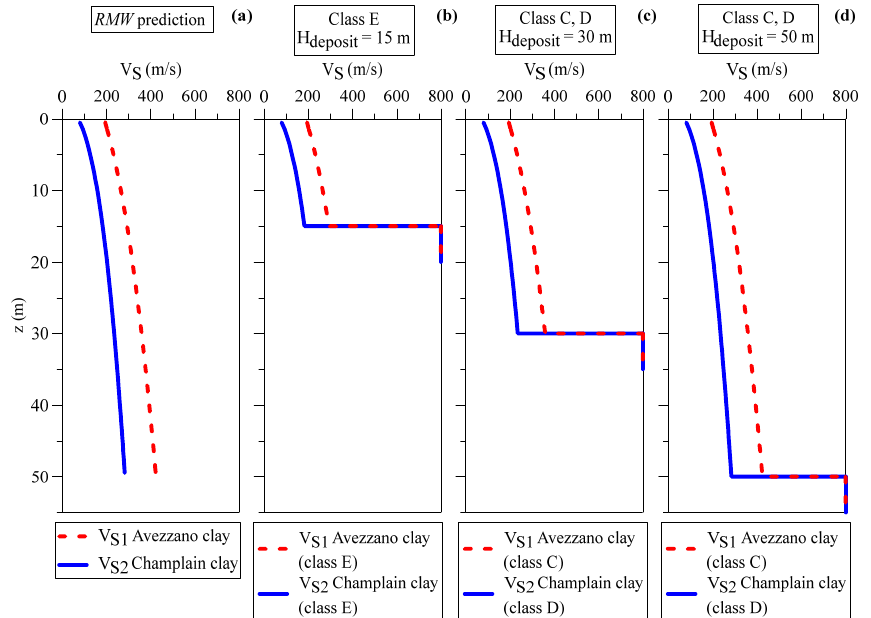
Figure 2. Shear wave velocity profiles adopted in the FE simulations: ( a ) RMW predictions based on the Viggiani and Atkinson formula (i.e., Equation (1)), ( b ) class E thin deposits (V S30 < 360 m/s, H deposit = 15 m), ( c ) classes C and D shallow deposits (V S30 < 360 m/s, H deposit = 30 m), and ( d ) class C and D deep deposits (V S30 < 360 m/s, H deposit = 50 m). In the figure, the EC8 soil class is also included for each considered deposit. H deposit stands for the depth of the seismic bedrock.